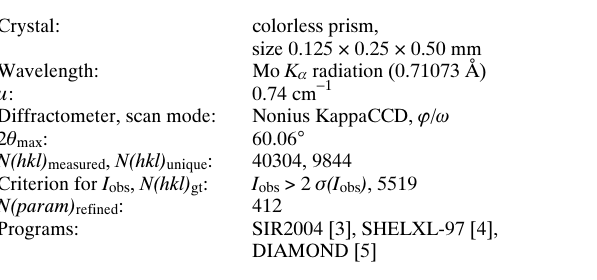
Table 1. Data collection and handling.